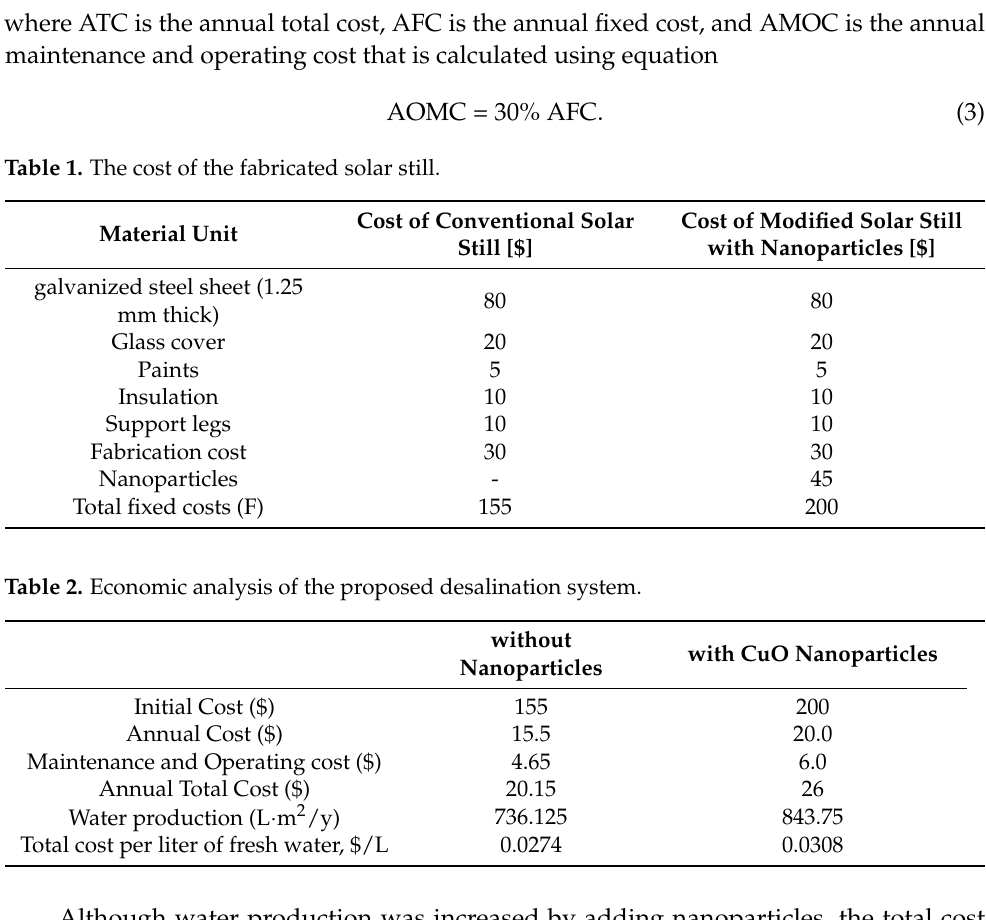
Cost of Conventional Solar Still [$]